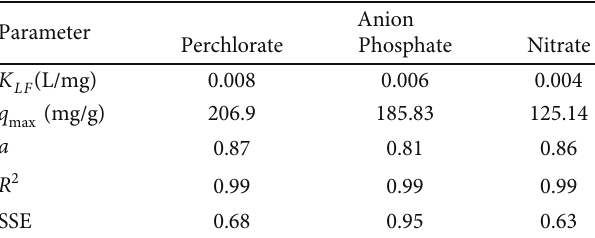
Table 1: L-F model parameters for anion adsorption.